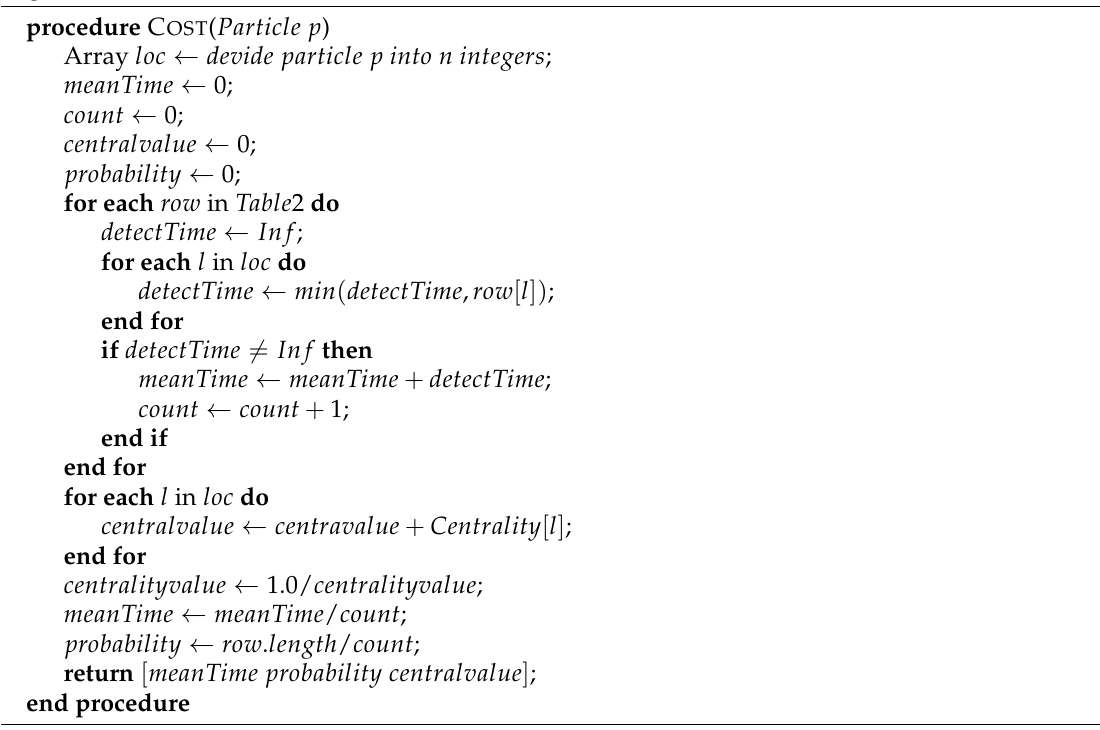
Algorithm A6 Pseudocode of cost function procedure C OST ( Particle p